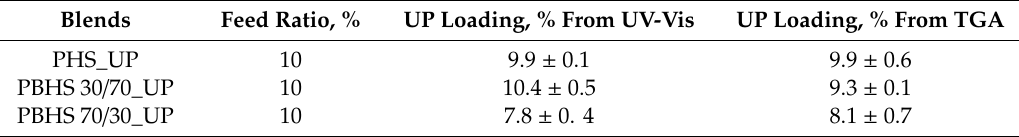
Table 3. Composite weight loading from dissolution / UV-Vis test and